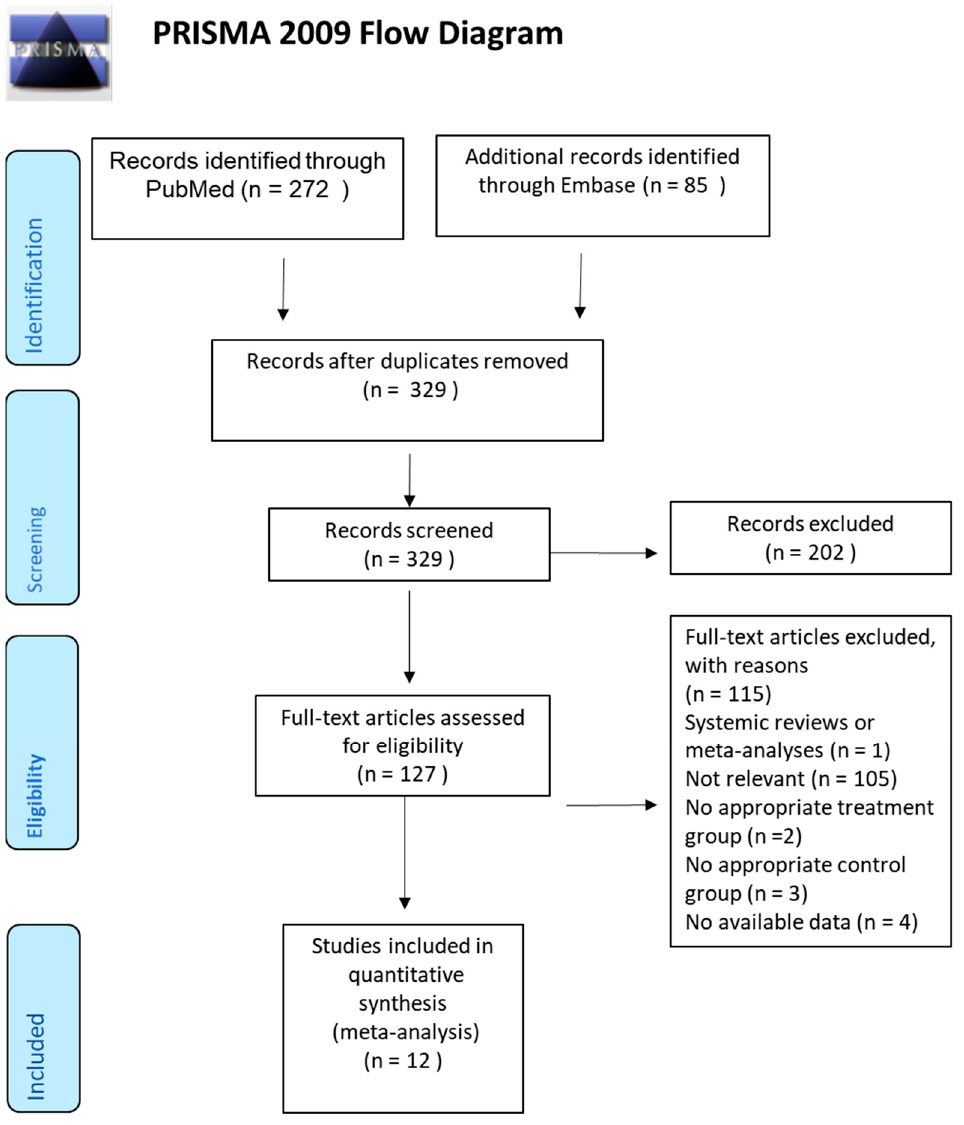
Figure 1. Preferred Reporting Items for Systematic Reviews and Meta-Analyses (PRISMA) flow diagram of included articles.